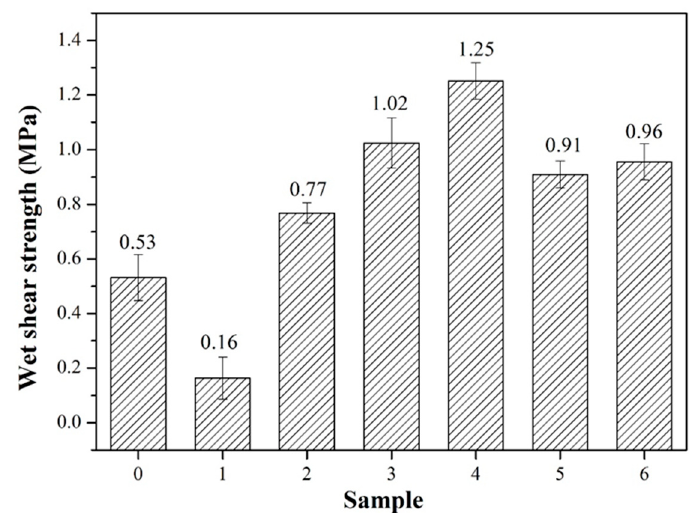
Figure 3. Wet shear strength of the different adhesive samples: 0 (12 wt% SPI), 1 (18 wt% SPI/bromelain), 2 (18 wt% SPI/bromelain/3 wt% TGA), 3 (18 wt% SPI/bromelain/6 wt% TGA), 4 (18 wt% SPI/bromelain/9 wt% TGA), 5 (18 wt% SPI/bromelain/12 wt% TGA), and 6 (18 wt% SPI/9 wt% TGA).